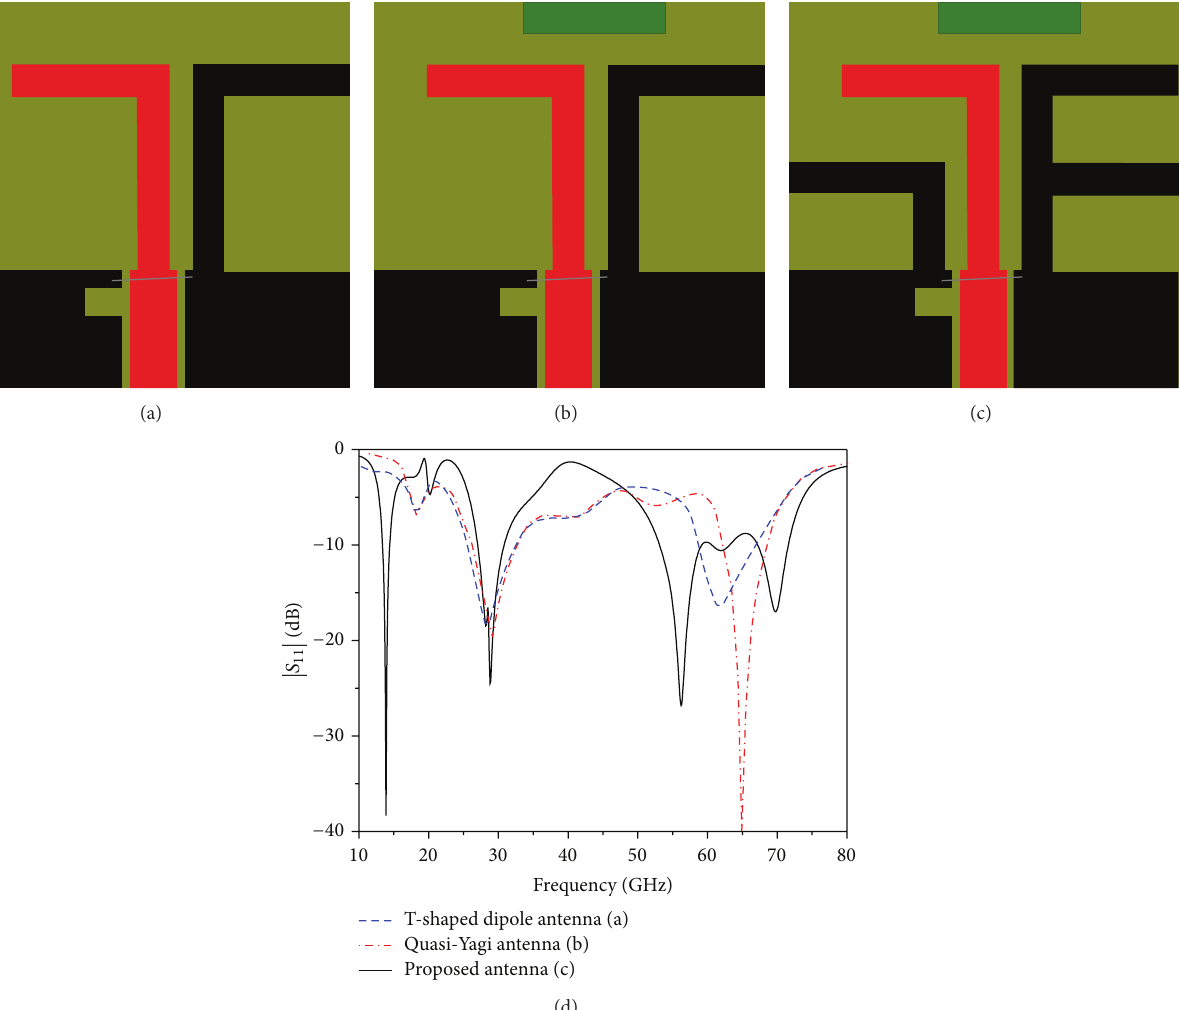
Figure 2: (a)–(c) Design steps of the proposed antenna and (d) |𝑆 11 | result response at each